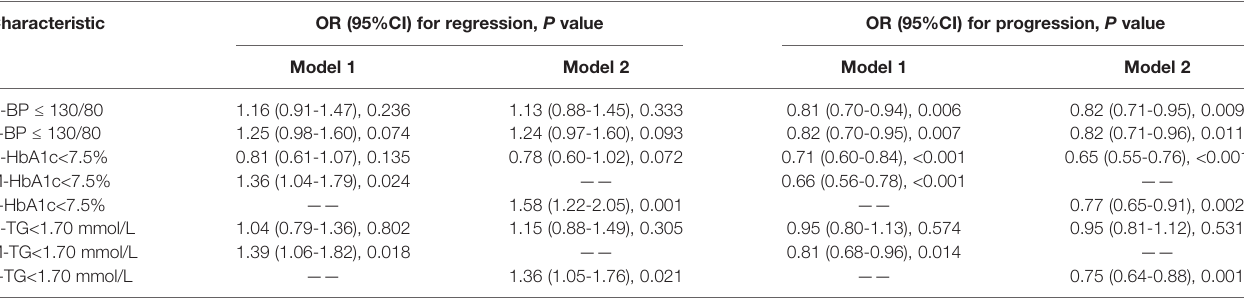
TABLE 4 | The association of ABC control and CKD